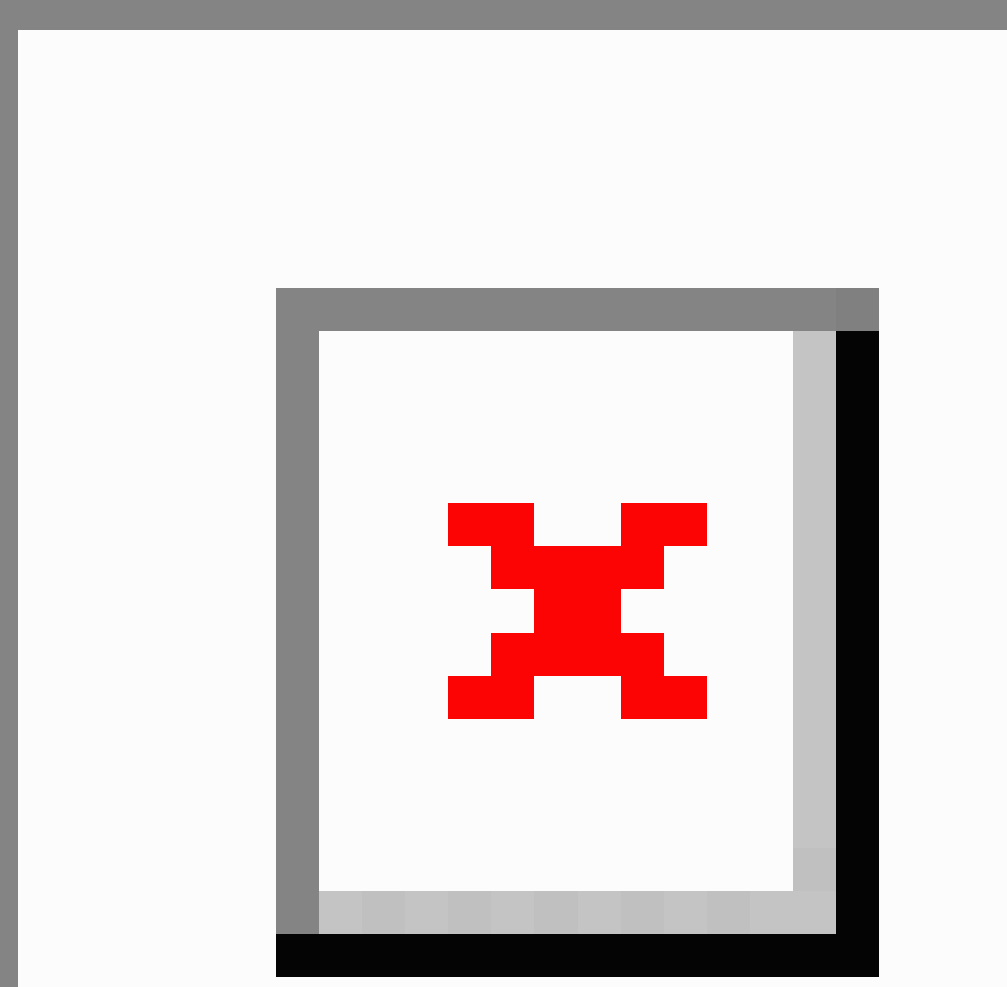
Figure 8. Boxplots of the distributions of Household type. Single parents show shorter sustained use than other household